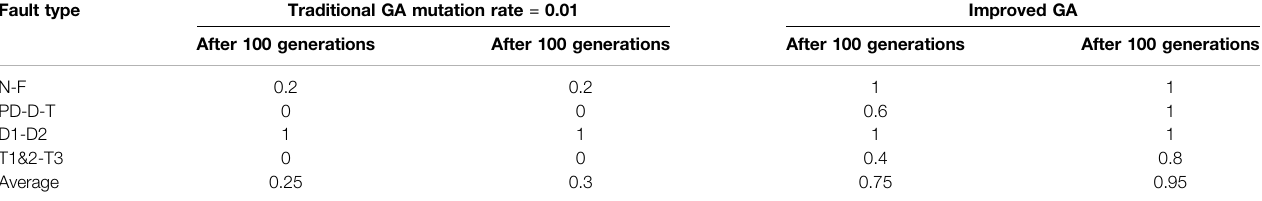
TABLE 5 | Likelihood of optimality Lopt(k